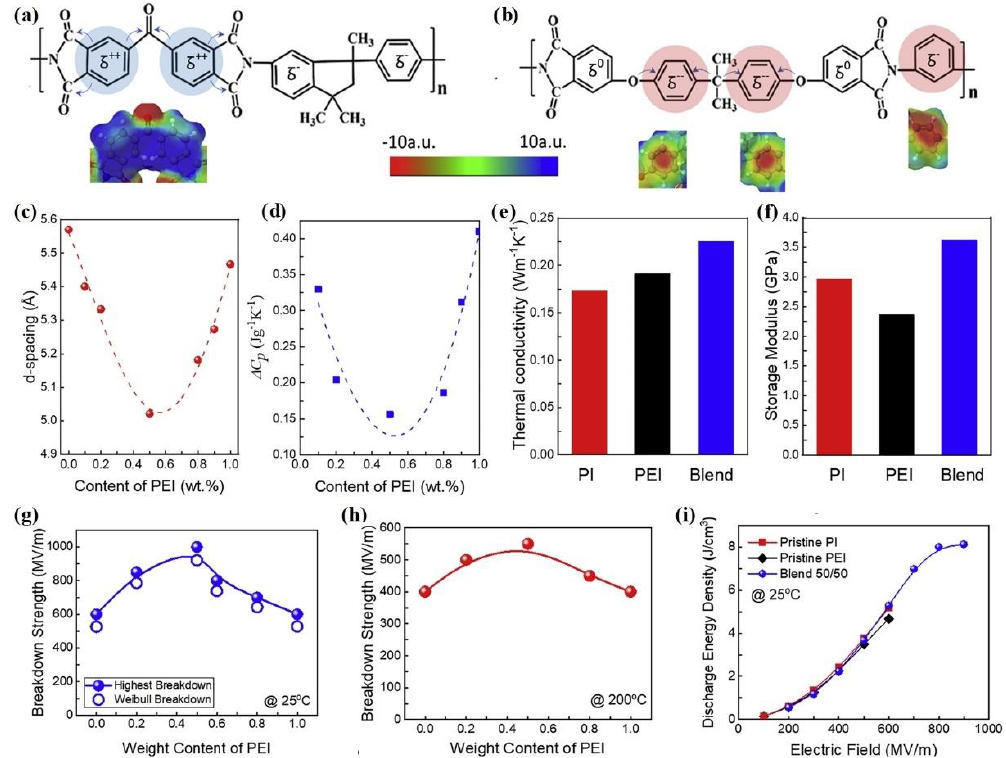
Figure 4. Schematic chemical structures of PI ( a ) and PEI ( b ). ( c , d ) Average interchain spacing ( c ) and the change in specific heat capacity during glass transition ( Δ C p ) ( d ) for PI/PEI blends with different ratios. ( e , f ) Thermal conductivity ( e ) and storage modulus ( f ) of pristine PI, PEI, and PI/PEI blend with a 50/50 ratio. ( g , h ) Dielectric breakdown strength as a function of the PI/PEI blend ratio at room temperature ( g ) and at 200 °C (h). ( i ) Discharge energy density of PI/PEI blend films under various electric fields at room temperature. Reproduced with permission from Ref. [53]. Copyright 2021, Elsevier.